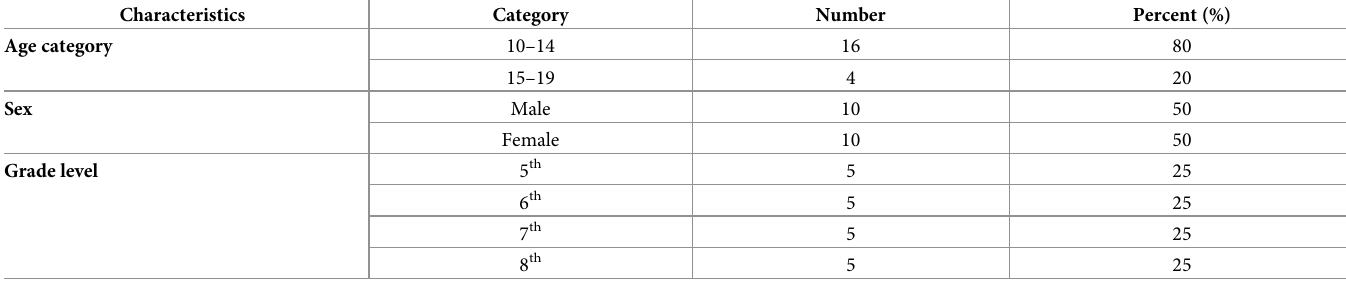
Table 2. Demographic characteristic of the students involved on development of poems to disseminate malaria message in Jimma zone, Oromia, Ethiopia, 2020.